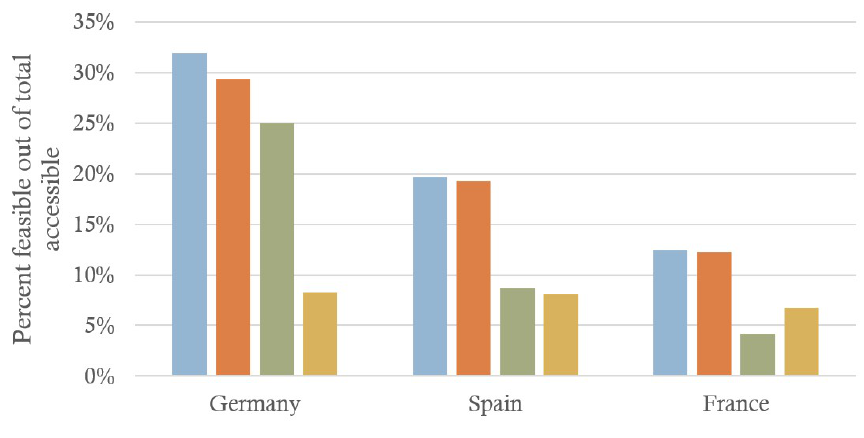
Figure 10. Feasible share of total accessible heat for the different heat sources and countries in 2050.